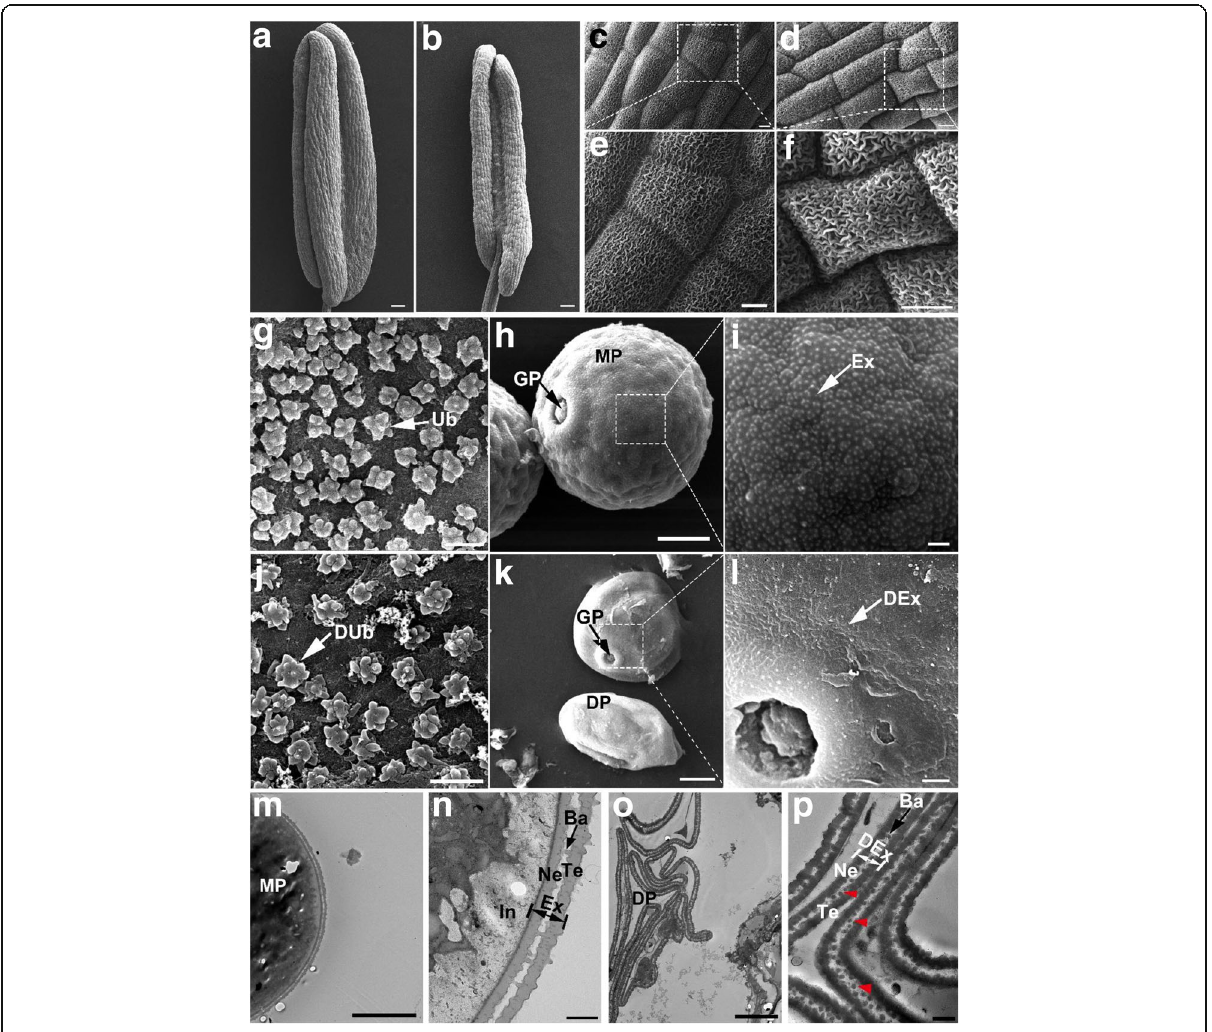
Fig. 3 SEM and TEM observation for the WT and oslap6 anther and pollen. a - l SEM analysis of the surfaces of anthers and pollen grains in the WT and oslap6 at stage 12. m - p TEM observation of pollen exine in the WT and oslap6 at stage 13. a and b Anthers of WT and oslap6 . c and e Anther epidermis of WT and oslap6 . d and f The enlarged images of epidermal surface of the WT and oslap6 anthers. g and j The inner surface of the WT and oslap6 anthers. h and k Pollen grains in the WT and oslap6 anthers. i and l Outer surface of pollen grains in the WT and oslap6 anthers. m and o Ultra-thin sections of pollen in the WT and oslap6 . n and p The magnified images of pollen exine in the WT and oslap6 , the arrows indicate the collapsed bacula. Ba, bacula; DEx, deformed exine; DP, degenerated pollen; DUb, deformed Ubisch body; Ex, exine; In, intine; GP, germination pore; MP, mature pollen; Ne, nexine; Te, tectum; Ub, Ubisch body; Scale bars =100 μ m ( a and b ); 10 μ m ( c – f , h , and k ); 1 μ m ( g , j , i , and l ); 2 μ m ( m ); 5 μ m ( o ); 500